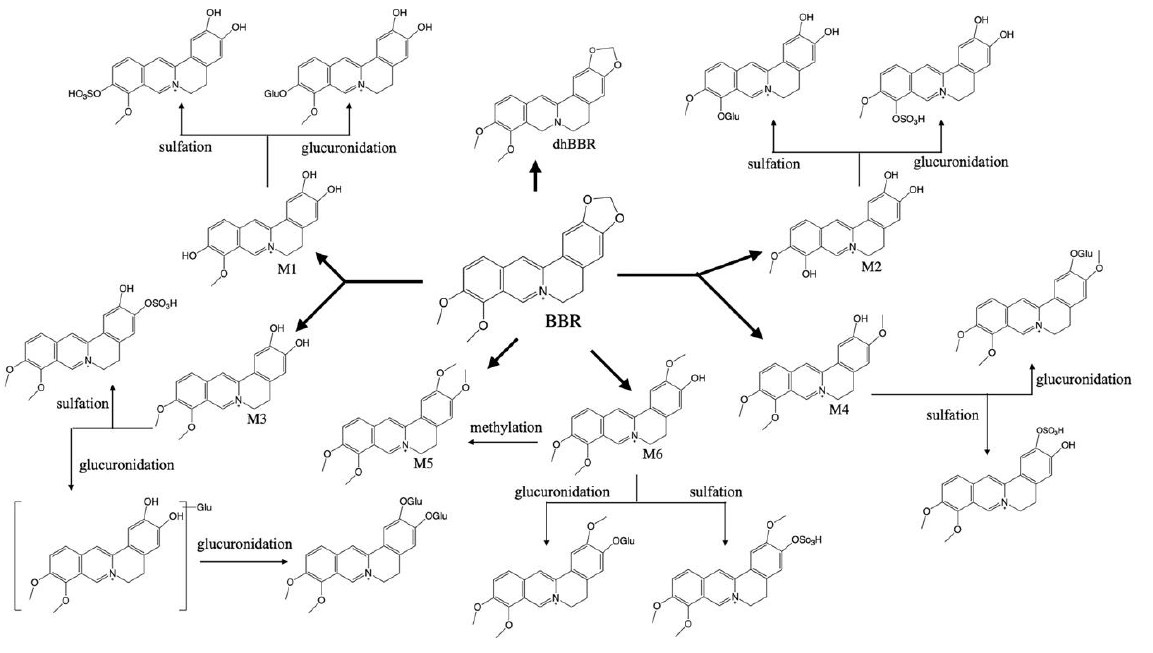
Figure 1. Metabolic pathway of